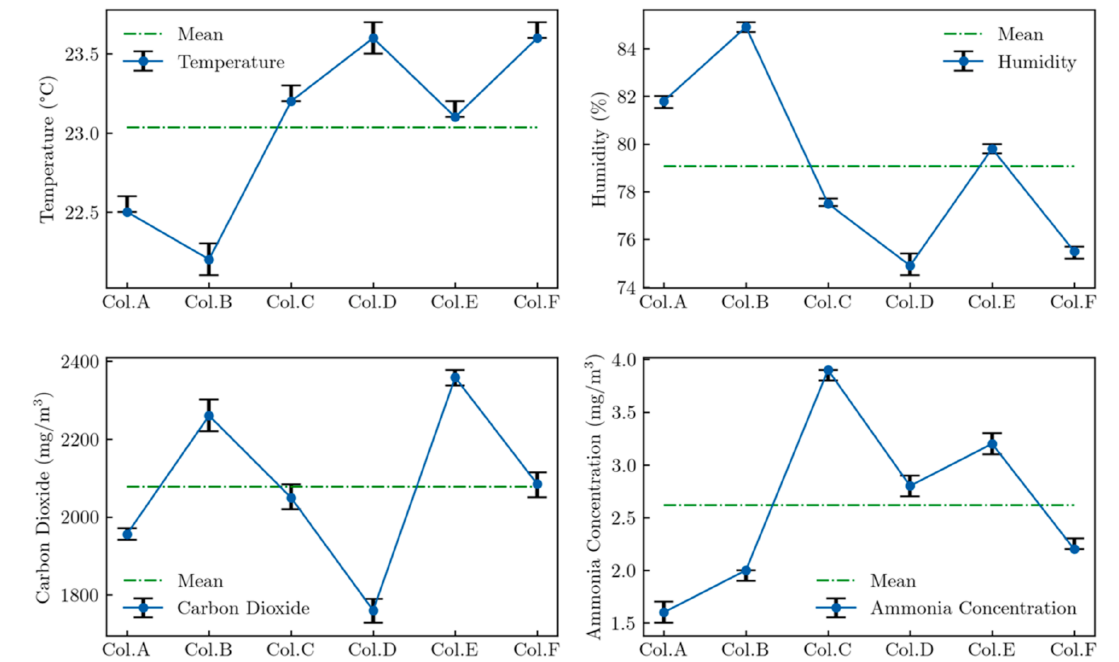
Figure 11. The 95% empirical bootstrap confidence intervals of means of four environmental parameters observed by the multisensor module of indoor slave